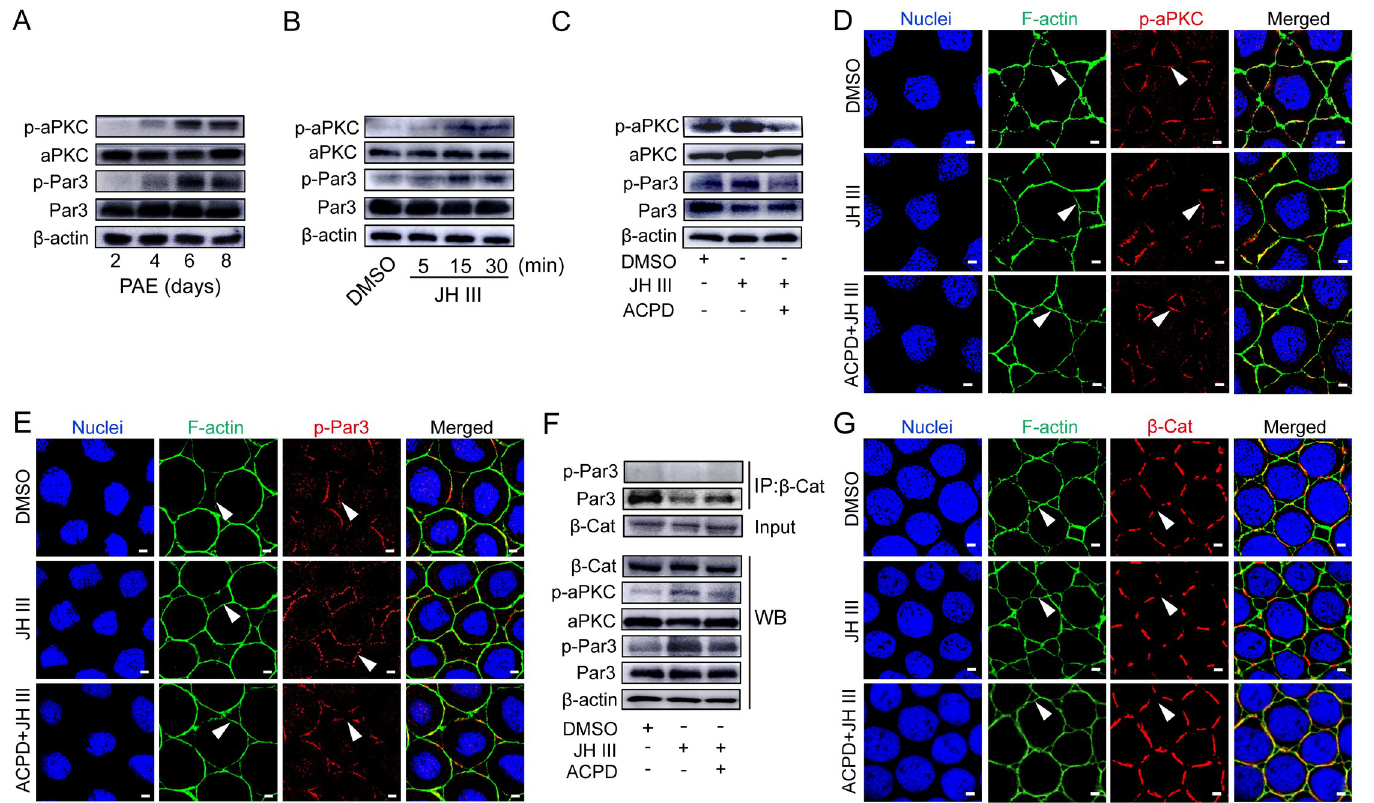
Fig 3. JH-induced phosphorylation of aPKC and Par3 as well as zonula adherens disassembly. (A) The levels of phosphorylated aPKC (p-aPKC) and Par3 (p-Par3) in the follicular epithelium of adult females during the first gonadotropic cycle. (B) Phosphorylation of aPKC and Par3 in cultured follicular epithelia of 7-day-old females treated by JH at 0.1 μ M for 5–30 min. (C) Suppression of ACPD on JH-induced aPKC and Par3 phosphorylation in cultured follicle cells of 7-day-old females. ACPD was applied at 0.1 μ M prior to JH treatment. (D) Distribution of p-aPKC in cultured follicular epithelium from adult females on day 8 and treated with DMSO, JH and ACPD +JH, respectively. Blue: nuclei. Green: F-actin. Arrow heads indicate patency. Scale bars: 5 μ m. (E) Distribution of p-Par3 in cultured follicular epithelia from adult females on day 8 and treated with DMSO, JH and ACPD+JH, respectively. Arrow heads indicate patency. Scale bars: 5 μ m. (F) Immunoprecipitation (IP) and Western blotting (WB) showing inhibition of ACPD on JH-induced disassociation of p-Par3 and β -Cat. (G) Distribution of β -Cat in the follicular epithelium treated with DMSO, JH and ACPD+JH. Arrow heads indicate patency. Scale bars: 5 μ m.